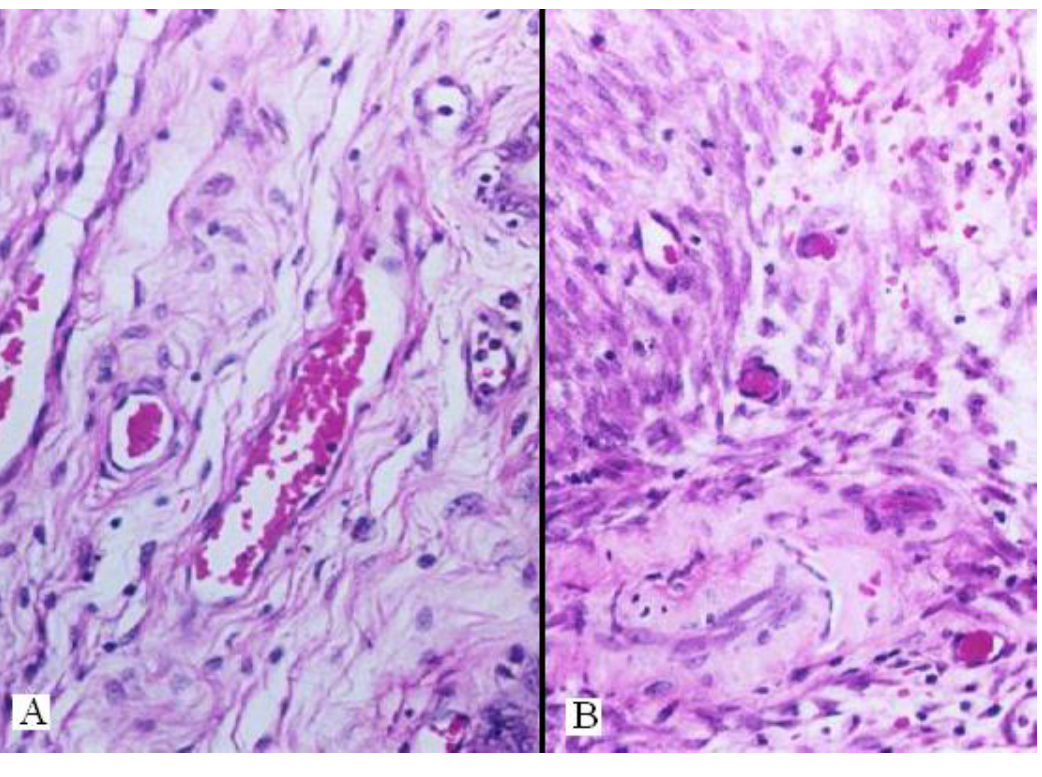
. B = large 3 healing tissue. Staining HE 1